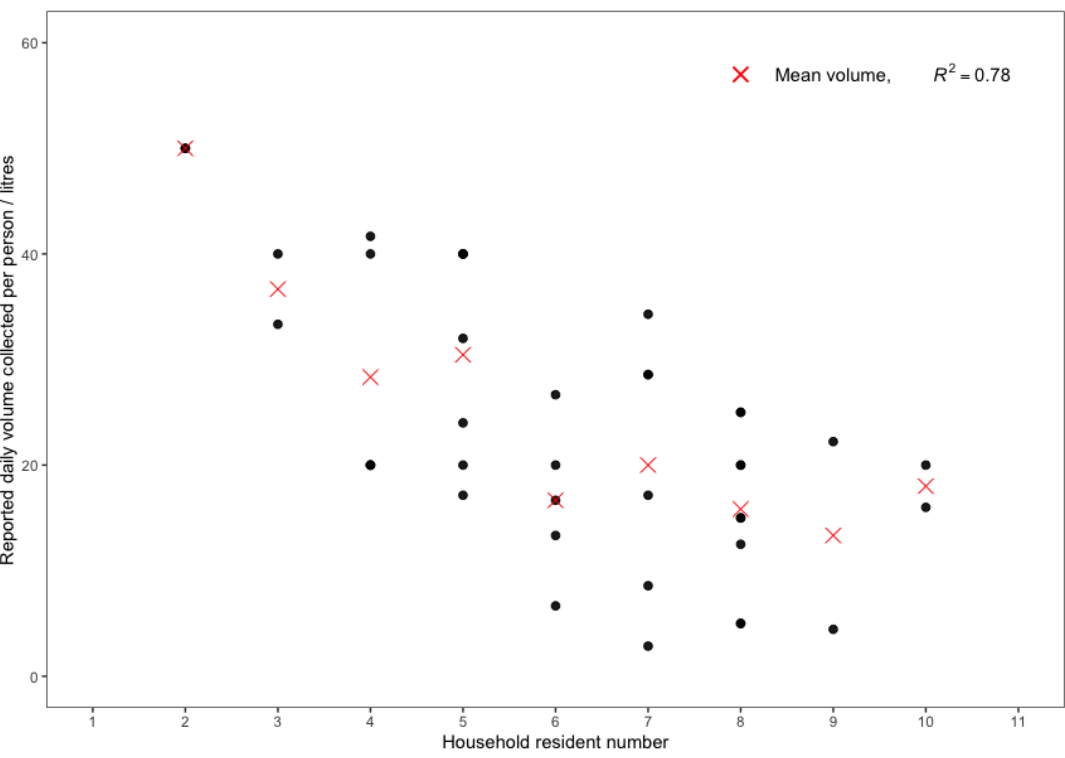
Figure 3. Average volume collected per day per person from DP against number of residents per household (not including n = 12 unquantifiable volumes and one outlier of 80 lpd for the teacher’s collection).